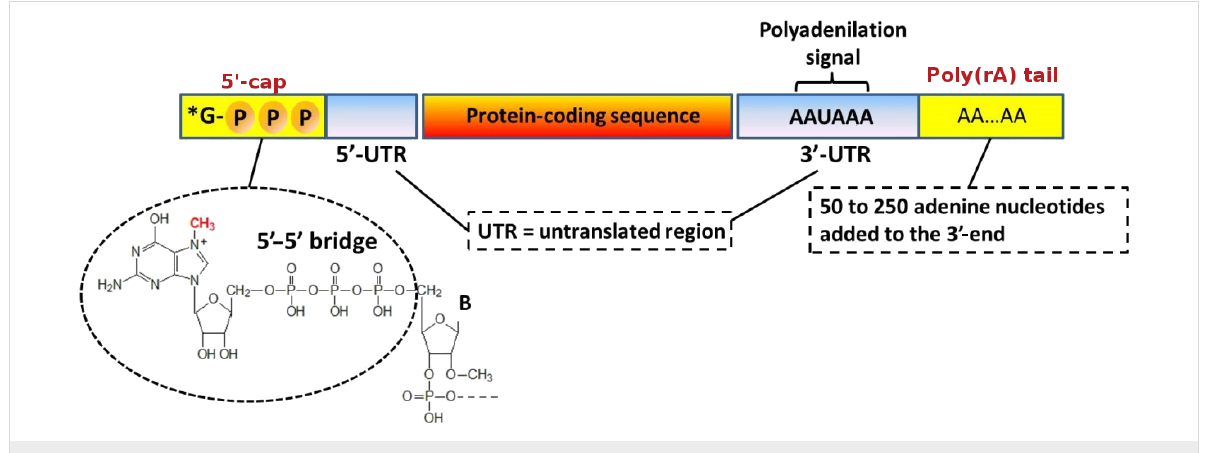
Figure 2: RNA processing begins with the addition of a 5'-cap and a 3'-poly(rA) tail to the pre-mRNA. The protein coding region contains coding sequences called exons. The exons are spliced together to form the mature mRNA.